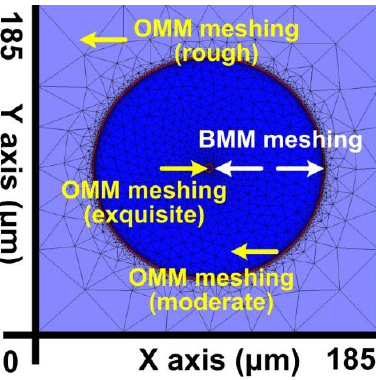
Figure 3. X–Y plane meshing resolution after using OMM and BMM in the FEM.